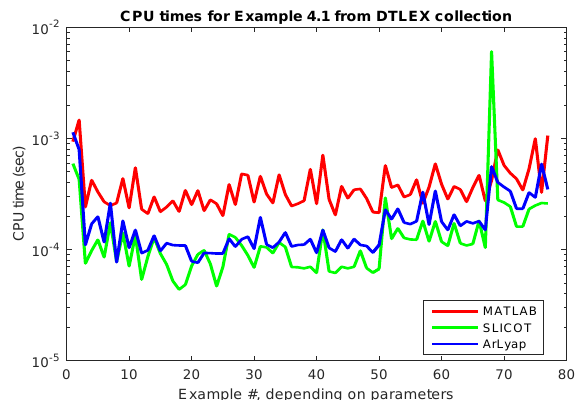
Figure 11. Elapsed CPU time for DTLEX 4.1 series of examples.